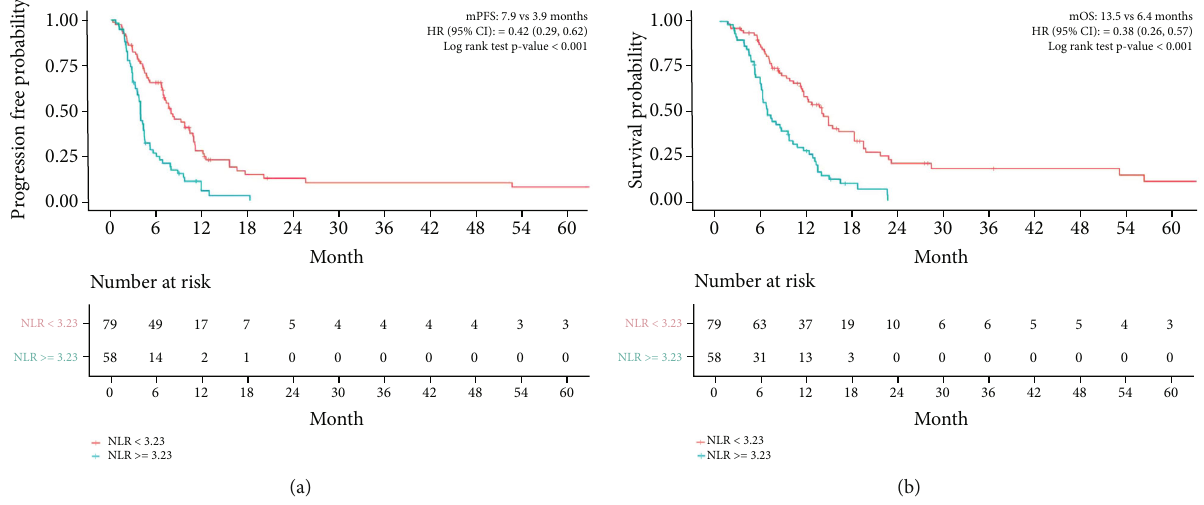
Figure 3: Progression-free survival (PFS) (a) and overall survival (OS) (b) in NLR based on the NLR cut-o ff value. Table 3: Univariate analysis and multivariate analysis of progression-free